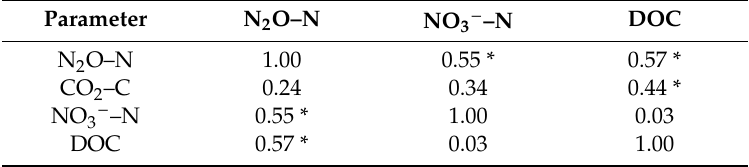
Table 4. Correlation coe ffi cients between cumulative N 2 O–N and CO 2 –C (total between 1st and 22nd and 23rd–51st day of experiment) emissions of the soil, and soil content of NO 3 − –N and DOC on 51st day of